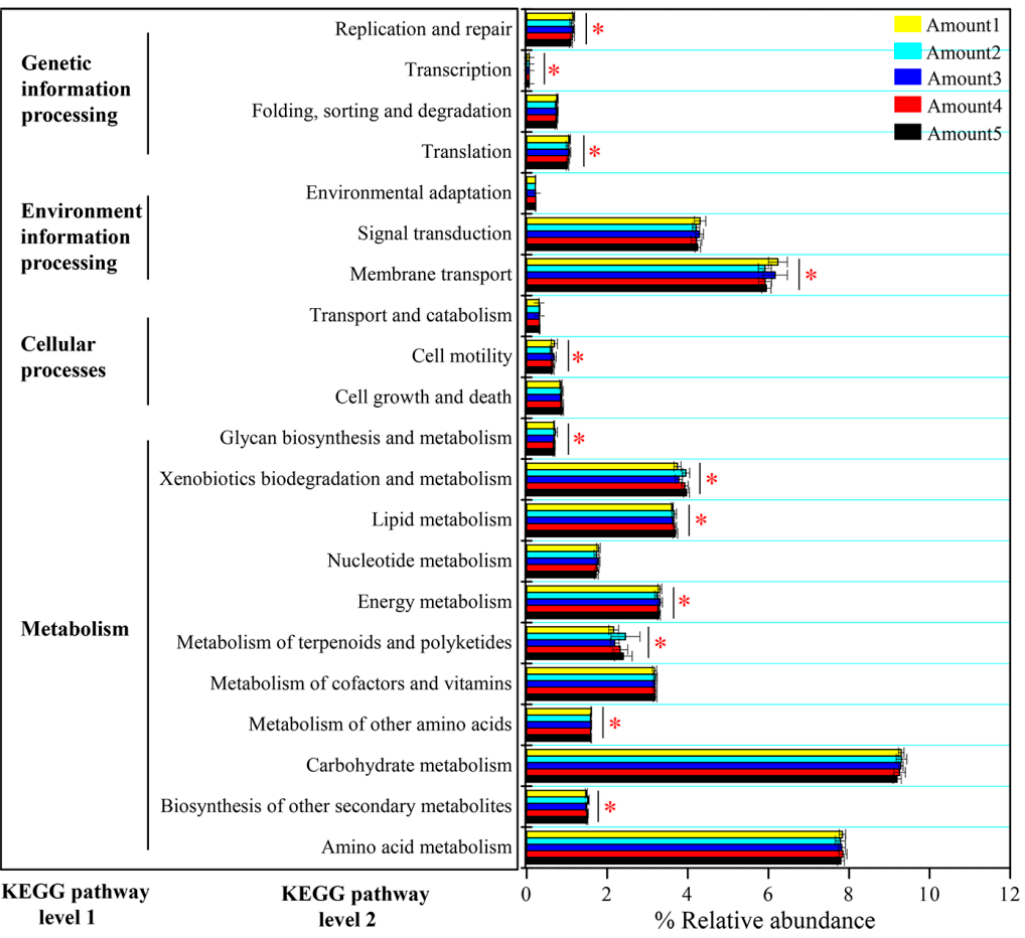
Figure 8. Function profiling showing divergences in bacterial functions at KEGG pathway levels 1 and 2 among five groups with different TiO 2 NP addition amounts. Asterisks denote significance (*, p < 0.05).